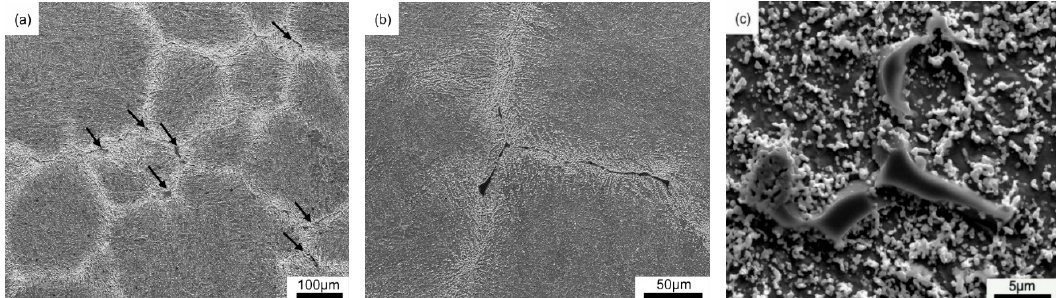
Figure 4. Distribution of primary and secondary carbides: ( a ) net ‐ like structure in the matrix of sample S1, ( b ) magnifying observation of the net ‐ like structure, and ( c ) primary carbide surrounded by secondary carbides (online version in color).